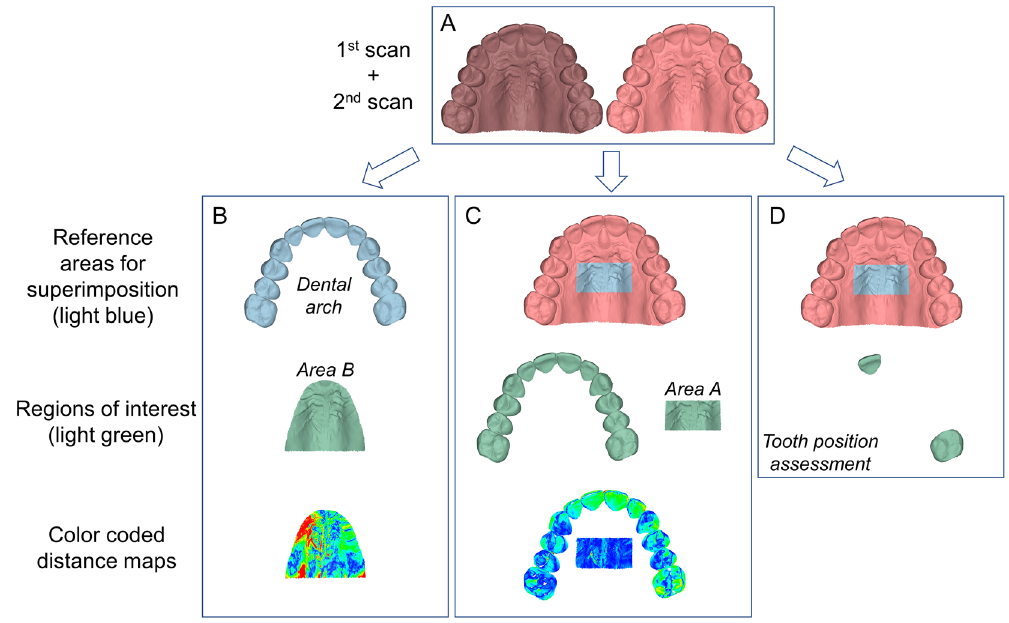
Figure 2. Superimposition and measurement process. ( A ) Repeated scans from the same scanner (either CS3600 or TRIOS3). ( B ) Superimposition procedure of repeated scans on the dental arch and associated assessments. ( C ) Superimposition procedure of repeated scans on area A and associated assessments. ( D ) Superimposition procedure of repeated scans on area A for the evaluation of spatial differences on two corresponding teeth of interest (central incisor and first molar). All images were generated using Viewbox 4 software (version 4.1.0.4 BETA, http:// www. dhal. com/ viewb oxind ex.